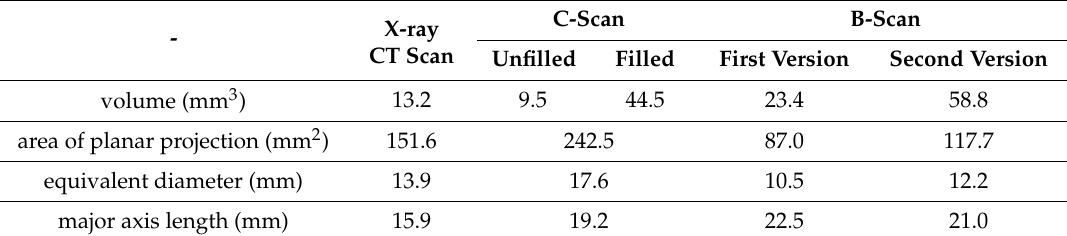
Table 1. Quantitative data of the reconstructed damage based on di ff erent NDT